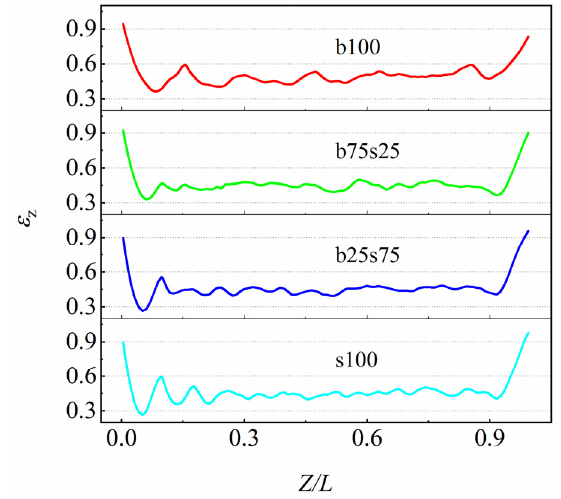
Figure 16. ( a ) Velocity distributions at different radial cross sections; ( b ) relative velocity distributions along the axial direction in different packed beds.